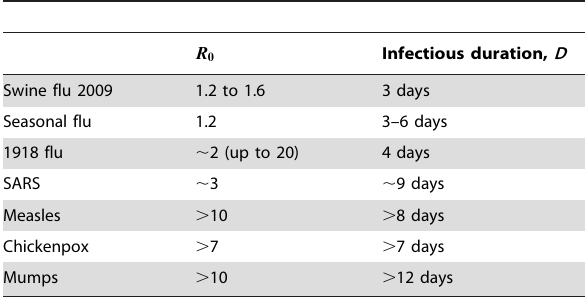
Table 1. Basic reproduction numbers and infectious durations for a number of communicable diseases.